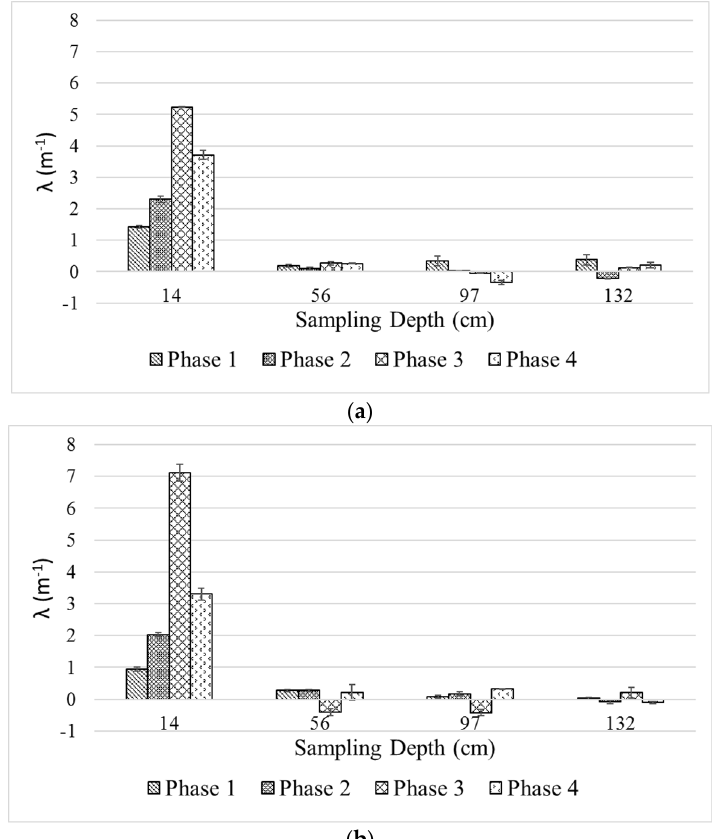
Figure 5. Filtration coefficients (λ) of ( a ) Column 1 and ( b ) Column 2 as a function of filter depth at different phases of the experiment.